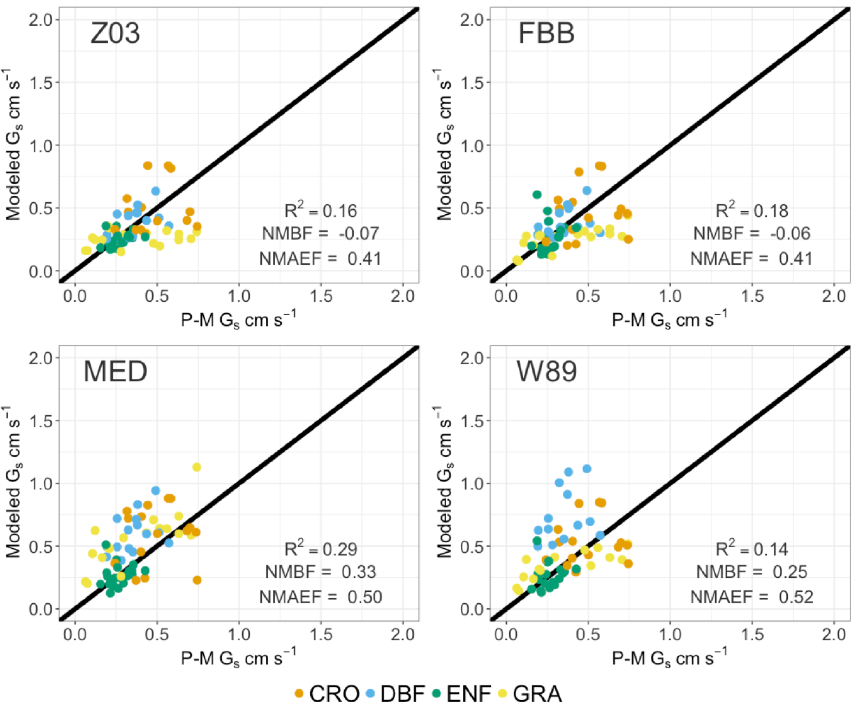
Figure 6. Simulated and SynFlux daytime average canopy stomatal conductance ( G s ) during growing seasons. Each point indicates daytime G s averaged over the growing seasons for the major PFT at one FLUXNET site. Table 4. Statistic summary of monthly average daytime canopy stomatal conductance with 2 standard deviations (cms − 1 ). DBF: deciduous broadleaf forest; ENF: evergreen needleleaf forest; CRO: crop; GRA: grass.